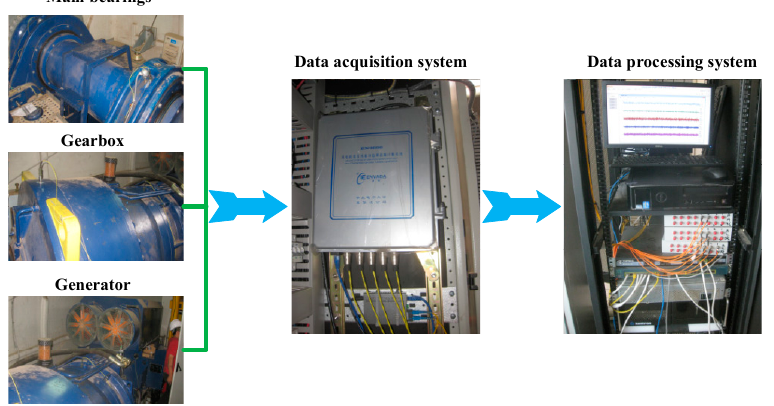
Figure 6. Online vibration data acquisition and analysis system for wind turbine drivetrain.